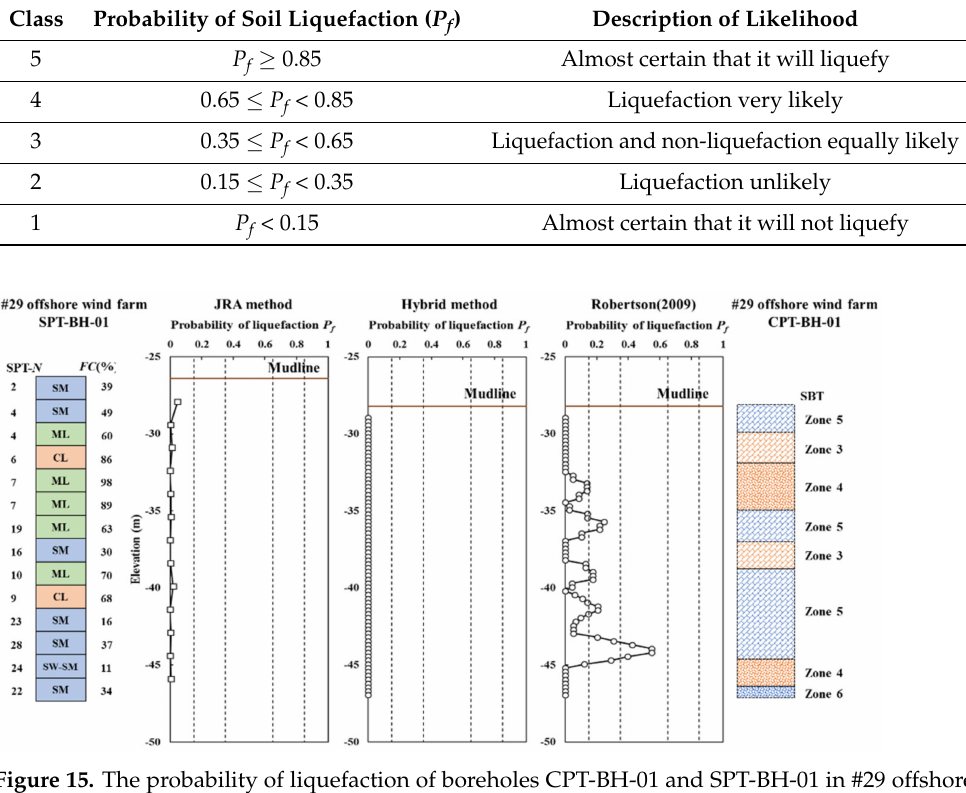
Figure 15. The probability of liquefaction of boreholes CPT-BH-01 and SPT-BH-01 in #29 offshore wind farm.